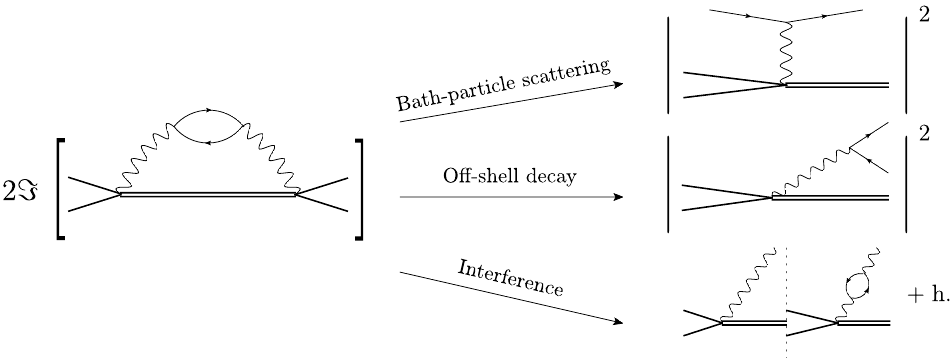
Figure 4 . Diagram shows contributions contained in the photon spectral function at next-to- leading